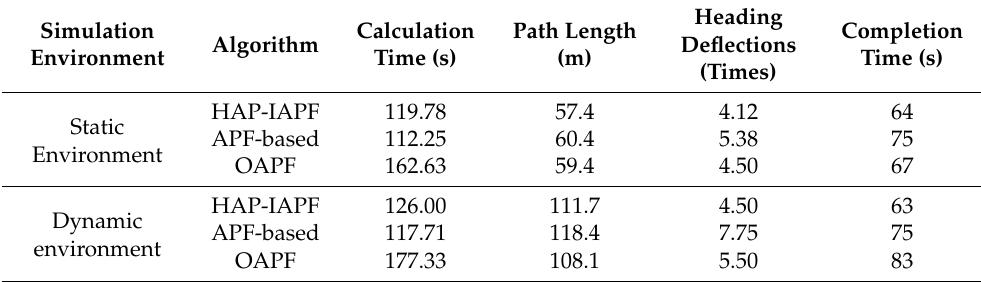
Table 4. Comparison of